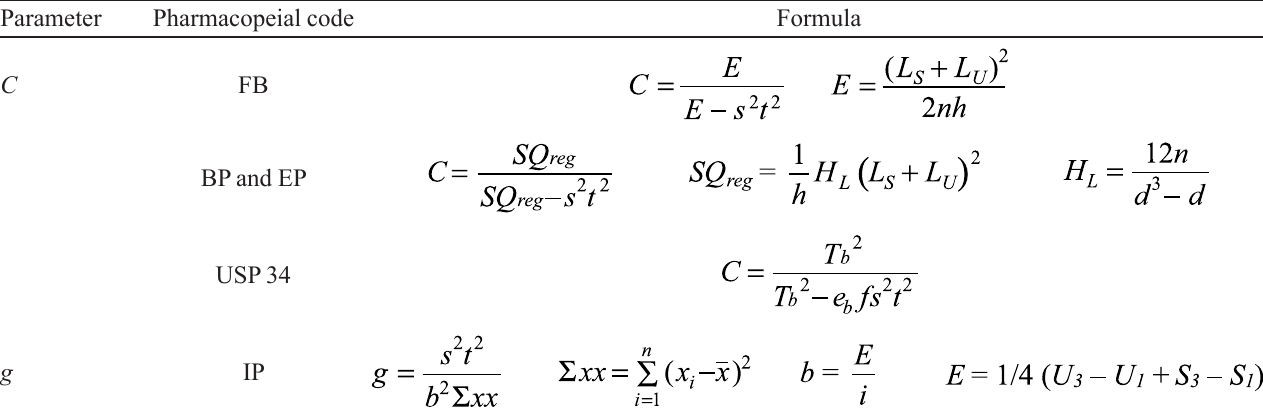
TABLE I - Formula for calculating the precision of the slope ( C or g ) used by the Brazilian Pharmacopeia (FB), The